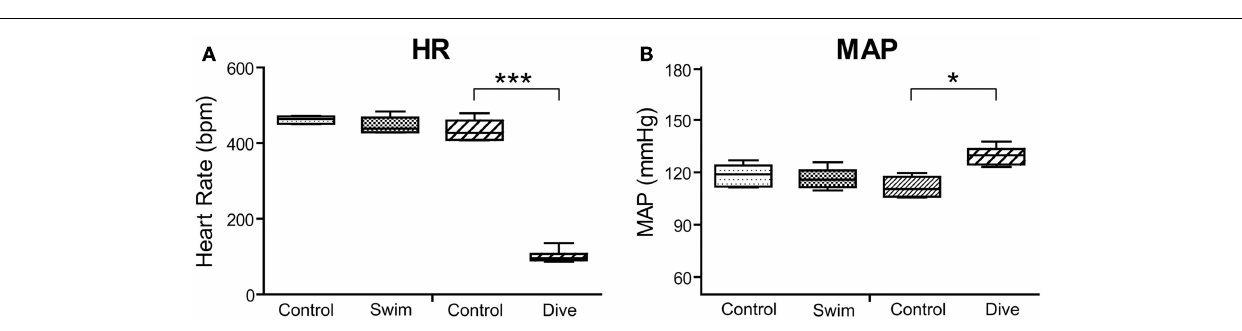
swam on the surface. Large down arrows indicate when the rat entered or submerged underwater while large up arrows indicate emersion from the water. ABP, arterial blood pressure; HR, heart rate.